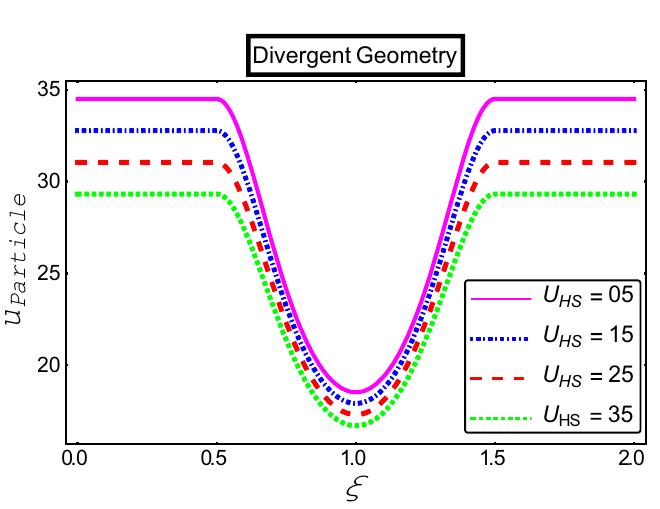
Figure 15. Impact of Helmholtz–Smoluchowski parameter on particle velocity.